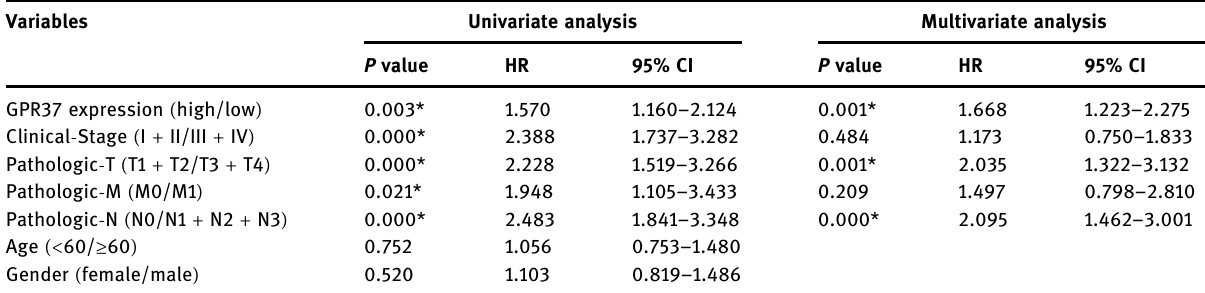
Table 2: Cox regression analysis indicated that GPR37 is an independent predictor of lung adenocarcinoma prognosis Variables